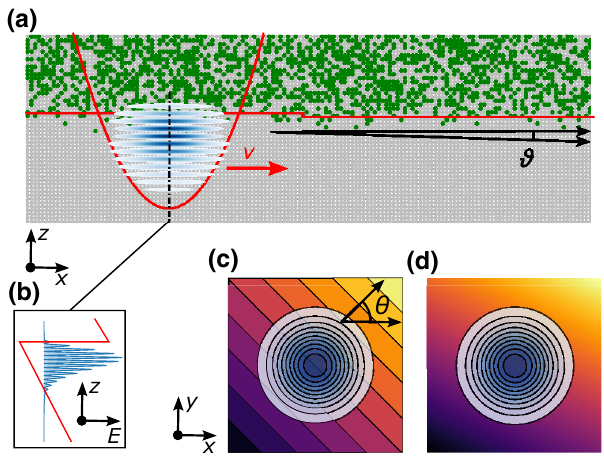
FIG. 11. Modeling of the local valley splitting across the SQS channel. (a) A 2D cross section through a Si/SiGe interface region with a gate-defined quantum dot containing the elec- tron. A single atomistic step is indicated at the center, with Ge-alloy disorder smearing out the location of the interface. Gray dots represent Si atoms in the strained Si layer and QW barrier region, respectively. Dark green dots represent Ge atoms. The angle ϑ indicates the average effective miscut. (b) A 1D line- cut along the growth direction, which is the model containing all short-range disorder discussed in the main text. The models describing long-range disorder in the 2D plane perpendicular to the growth direction are sketched in (c) (step model) and (d) (gra- dient model), with the color coding indicating the continuous and discrete spatial variation in valley phase, respectively. The angle θ in (c) is the angle between the step normal and shuttling